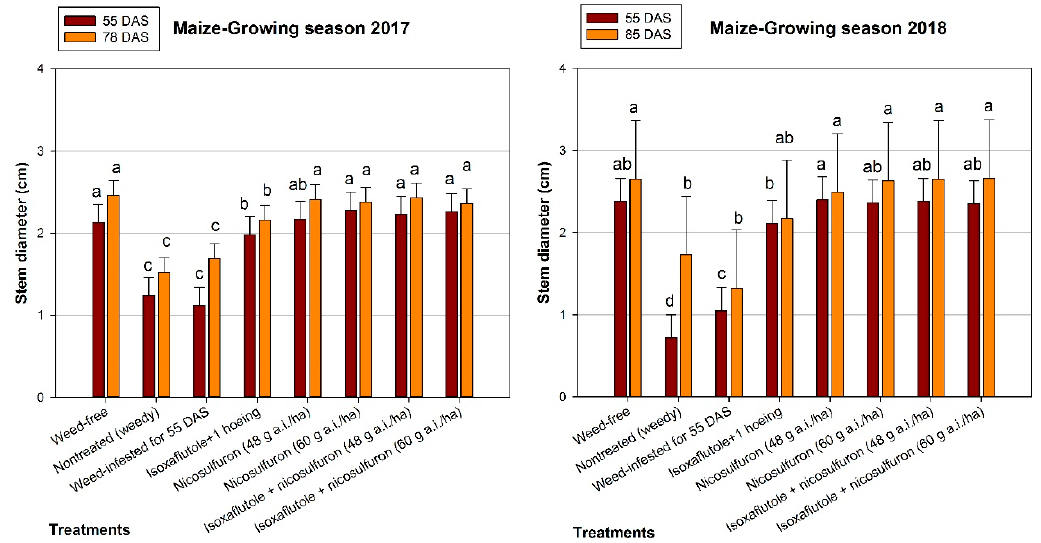
Figure 4. Maize stem diameter as affected by the various treatments at 55 days after sowing (DAS) and 78–85 DAS, in 2017 and 2018 (Velestino, Greece). For each measurement, bars followed by different letters indicate significant differences according to Fisher’s LSD test ( p ≤ 0.05). Error bars indicate the LSD 5% values.